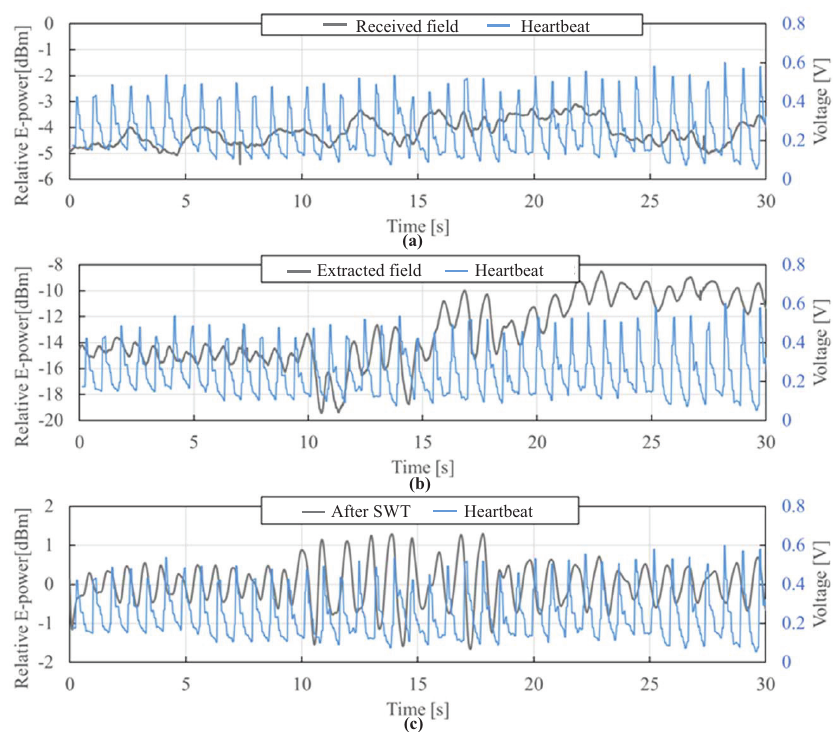
Figure 13. Experimental result. ( a ) time waveform of received electric field; ( b ) time waveform of extracted transmitted electric field; ( c ) time waveform of extracted transmitted electric field after SWT. Table 2. Estimated heart-rate in the verification experiment. Reference Without Extr . With Extr . With Extr . & SWT 78 89